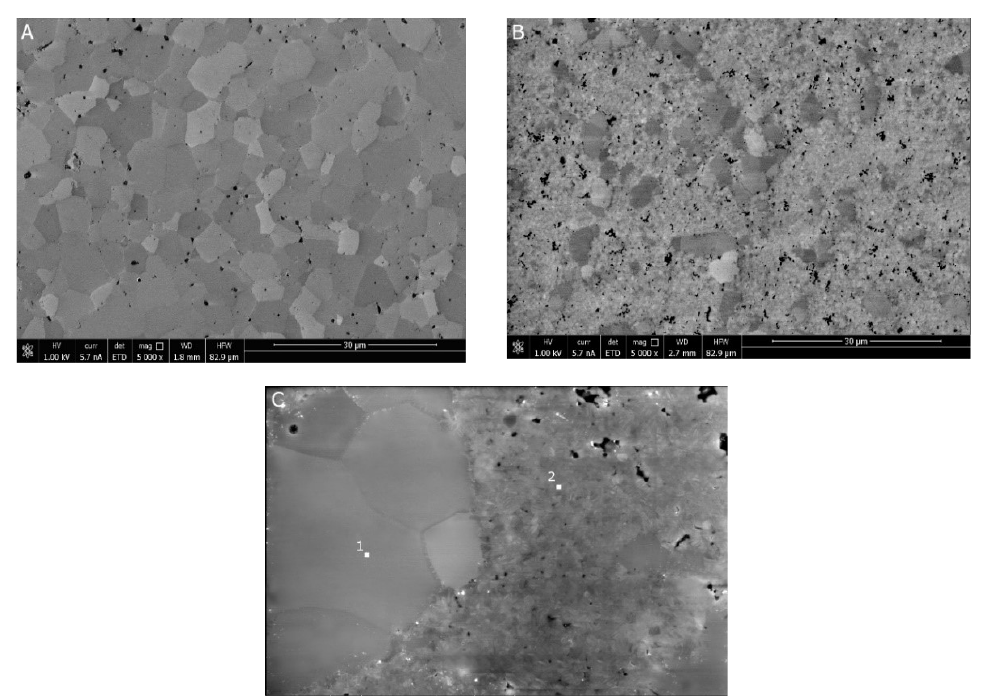
Figure 5. SEM images of the microstructures of the materials sintered at 1450 °C for 2 h: ( A ) Material of 11.5 mol% MgO; ( B ) Material of 7.4 mol% MgO; ( C ) The same material as B but under higher magnification. EDS analyses show 5.5 at% Mg at point 1 and 2.8 at% Mg content at point 2.